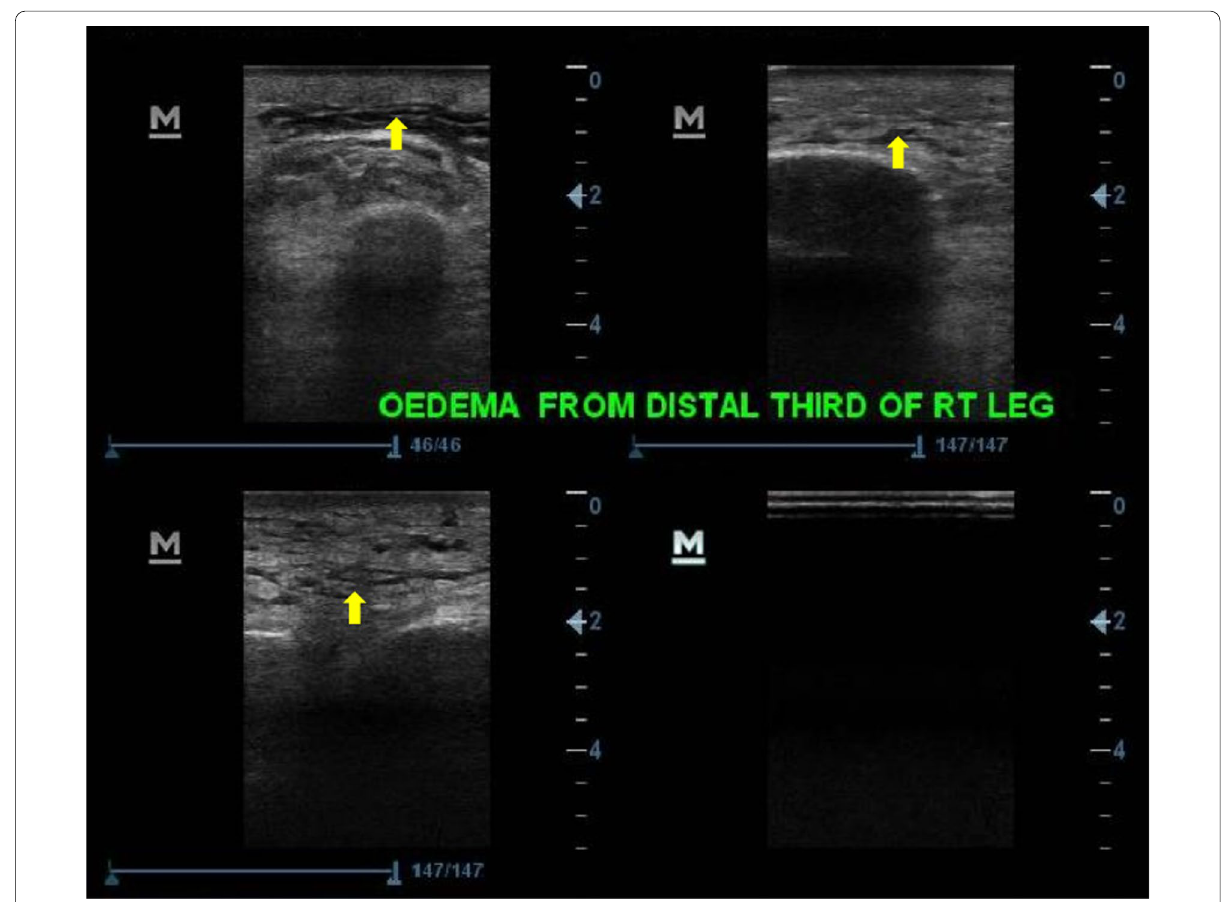
Fig. 5 Ultrasound images of the right lower limb performed for a 66‑year‑old male who reported with a four‑day history of swelling of the right lower limb and fever of two‑day duration. It shows multiple hypoechoic fluid accumulation in the subcutaneous layer of the distal third of the right leg as indicated with the yellow